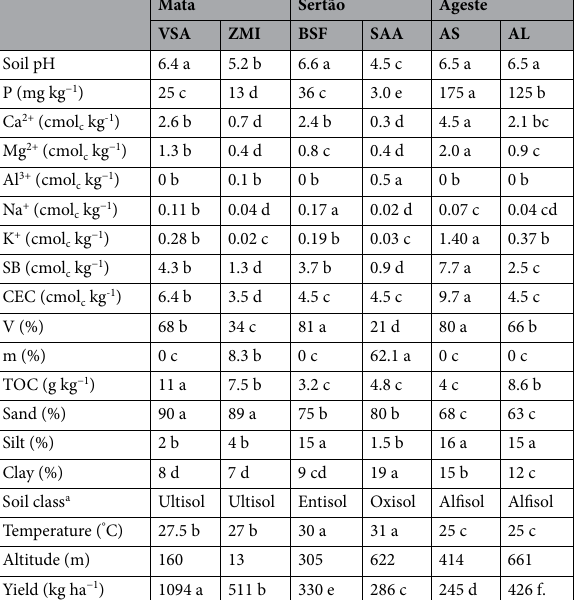
Table 1. Soil properties, temperature, altitude, and cowpea yield of the evaluated location. a Soil Taxonomy; SB sum of basis, CEC cation exchange capacity, V (%): basis saturation, m (%) Al 3+ saturation, TOC total organic carbon, VSA Vitoria de Santo Antão, ZMI, Itapirema; AS, Surubim; AL, Lajedo; BSF Belém do São Francisco, SAA,